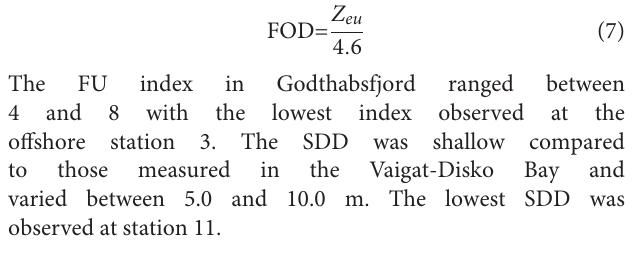
over the euphotic depths, K par ( Z eu ), were also determined from the measured PAR profiles. The K par ( Z eu ) coefficients ranged from 0.10 to 0.22 m − 1 in the Vaigat-Disko Bay. Minimum